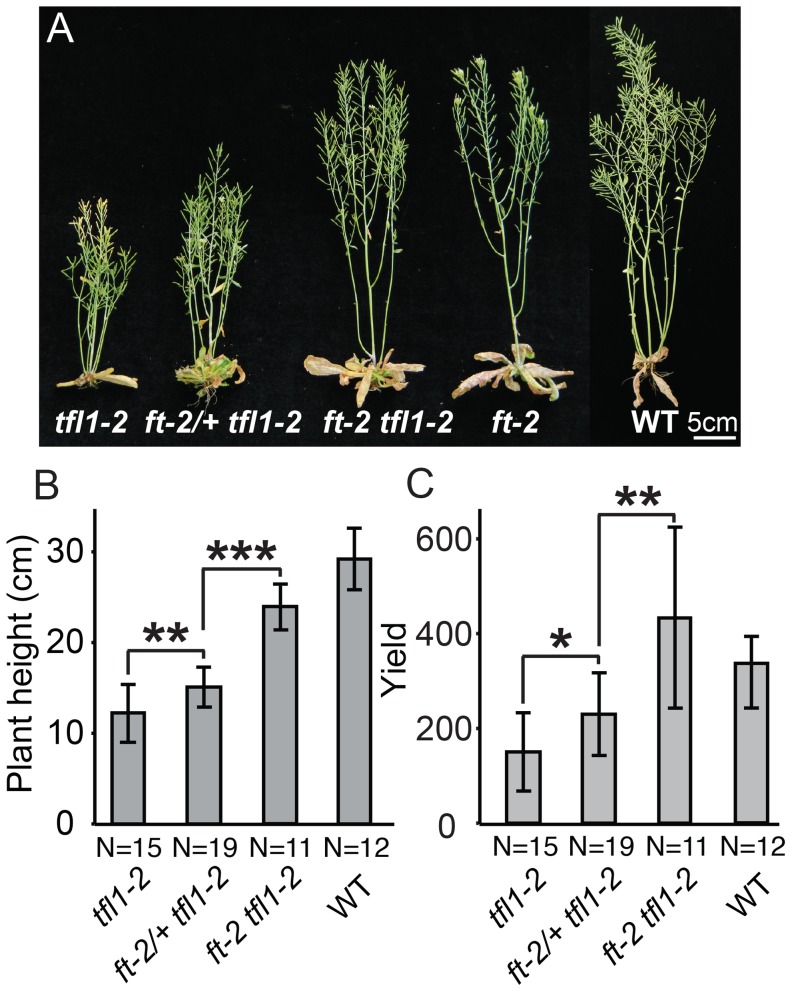
Dose-dependent suppression of tfl1 (sp) by ft/+ (sft/+) heterozygosity is conserved in Arabidopsis thaliana.(A) Representative plants from left to right of: tfl1-2 single mutants, ft-2/+ tfl1-2, ft-2 tfl1-2 double mutants, ft-2 single mutants and wild type Ler-0 (WT) showing the intermediate height of ft-2/+ tfl1-2 plants compared to tfl1-2 and ft-2 tfl1-2 genotypes. (B–C) Statistical comparisons among all genotypes for plant height and flower/fruit yield showing semi-dominant effects from ft-2/+heterozygosity in the tfl1-2 background. Bars indicate average values with standard deviation. Genotypes and sample size are shown below. Differences between genotypes were tested by a Wilcoxon rank sum test and significance levels are marked by asterisks (*P<0.05, **P<0.01, ***P<0.001). (B) ft-2 heterozygosity in a tfl1-2 mutant background partially suppresses the early flowering and early termination phenotype of the tfl1-2 mutation in a semi-dominant manner, resulting in plant height in between tfl1-2 and ft-2 tfl1-2 mutant parental lines. (C) Unlike tomato, ft/+ heterozygosity in a tfl1-2 mutant background does not drive heterosis for yield (number of total siliques and floral buds) in Arabidopsis. Rather, yield in the ft-2/+ tfl1-2 plants is intermediate to tfl1-2 and ft-2 tfl1-2 double mutants.